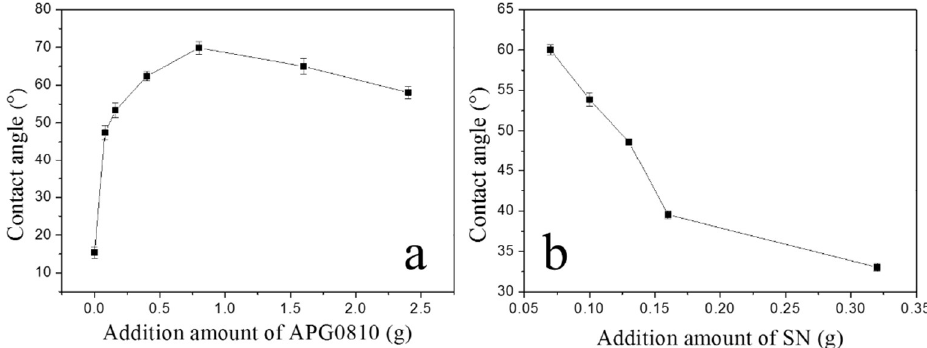
Figure 3. The apparent contact angle curves of MMG ( a ) and MMO ( b ) with different additional amounts of APG and SN.